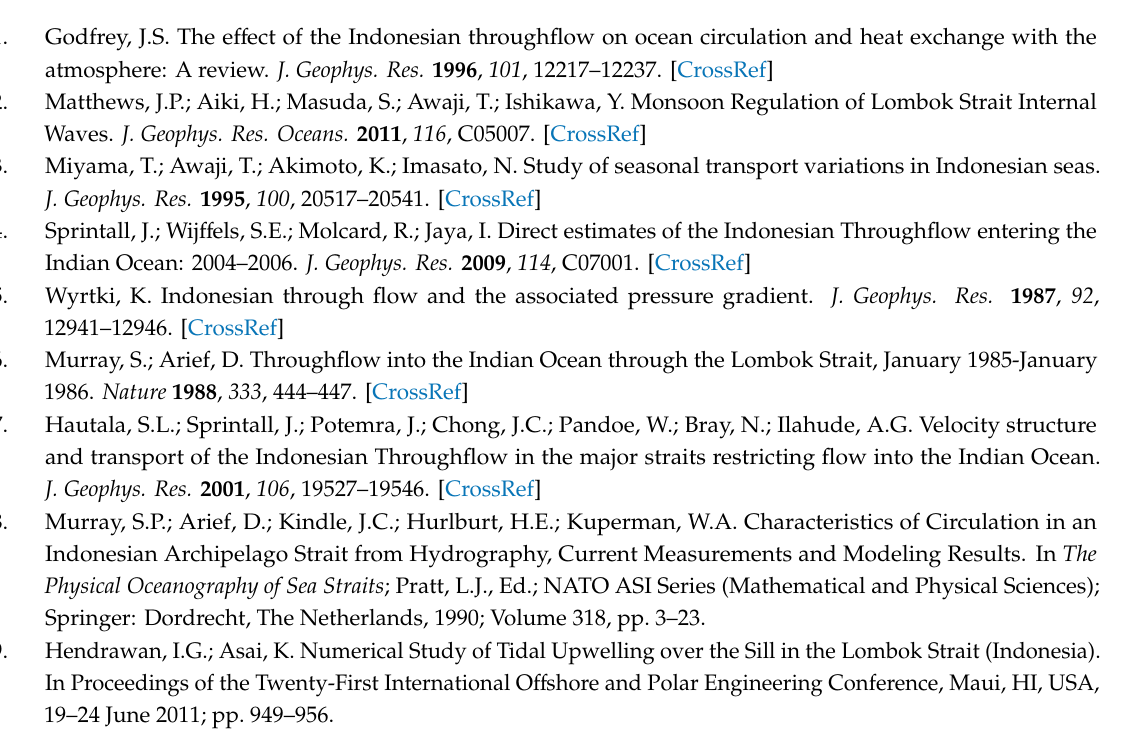
Figure A4. Left panel: maximum (upper) and minimum (bottom) variation of the density gradient for two approaches; right panel: total energy (kJ) for hydrostatic and nonhydrostatic statement for all periods of simulation.